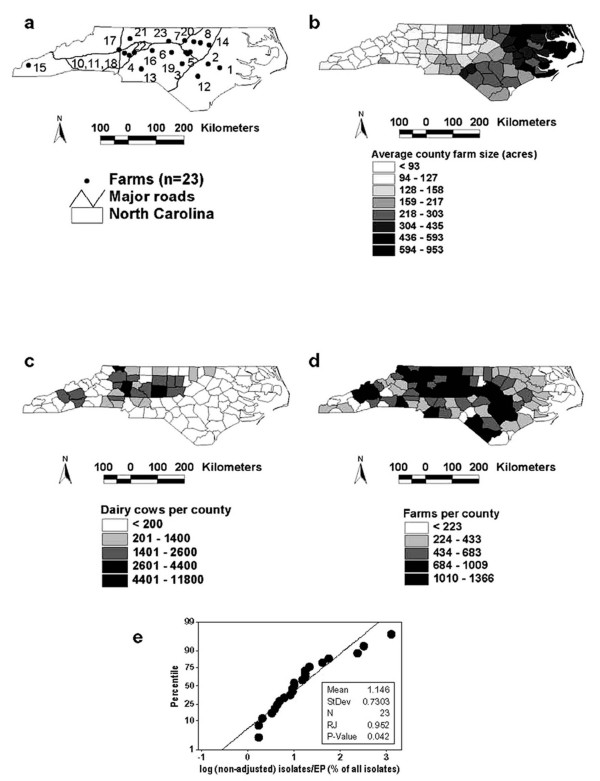
Spatial context. Spatial location of: investigated farms and road network (a), farm size (b), dairy cows/county (c), and (farms/county d). The Ryan-Joiner (RJ) test indicated that the (log) number of isolates/EP for the 24 microbial genotypes (EP) found in ≥ 2 isolates (interfarm EP ratio) differed significantly (P < 0.05) from a normal distribution (diagonal line, e).